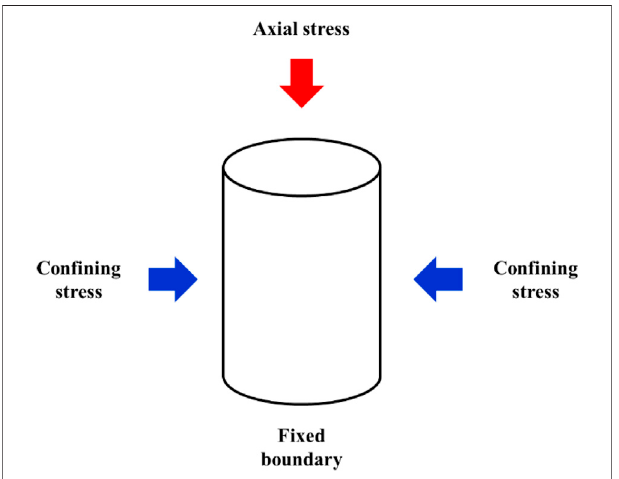
FIGURE 4 | Three-dimensional geometry of the model.